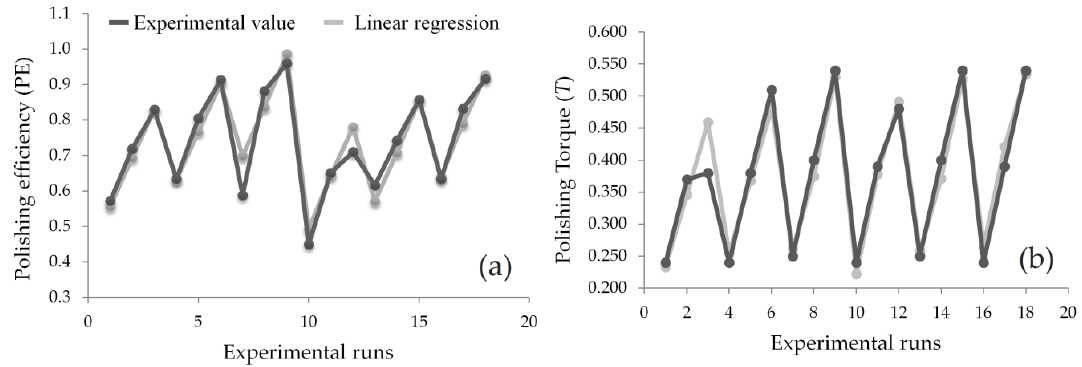
Figure 8. Predicted results against experimental results: ( a ) for polishing efficiency; ( b ) for torque.